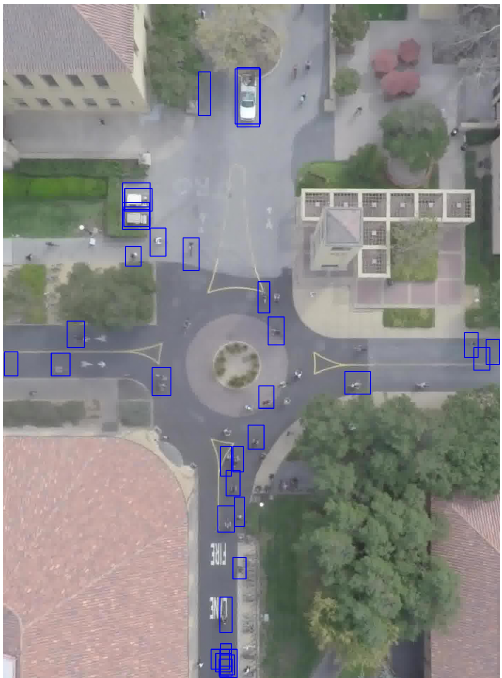
Figure 5. A sample image of the Stanford dataset, with ground-truth bounding boxes showing some annotation errors and